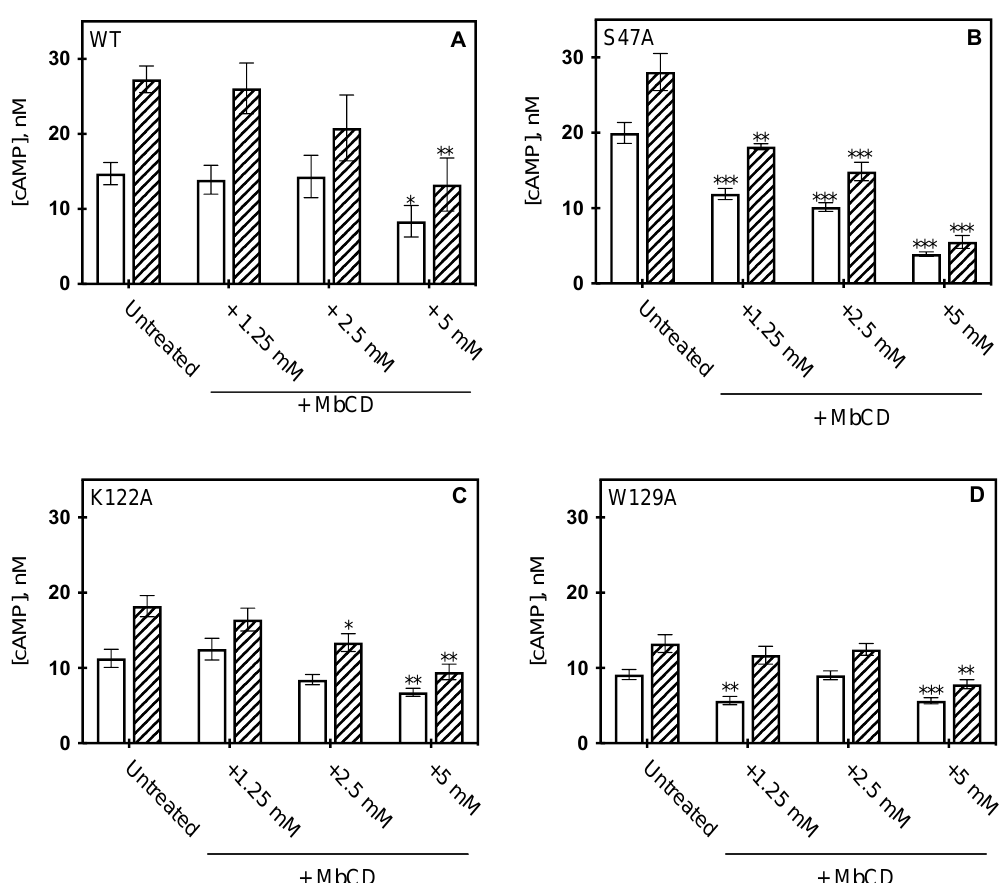
Figure 5. Effect of M β CD on CCM variants. cAMP concentration measured from HEK293 cells expressing wild type A 2A R ( A ) S47A ( B ) K122A ( C ) and W129A ( D ) following M β CD addition, in the presence (hatched) or absence (open) of 1 µ M CGS21860 (a selective agonist for A 2A R). cAMP was measured as described in materials in methods, where the bars represent the mean ± S.E.M error bars from n = 3 experiments performed in triplicate. * p < 0.05, ** p < 0.005, and *** p < 0.0005 are significantly different from the untreated control for MβCD addition.